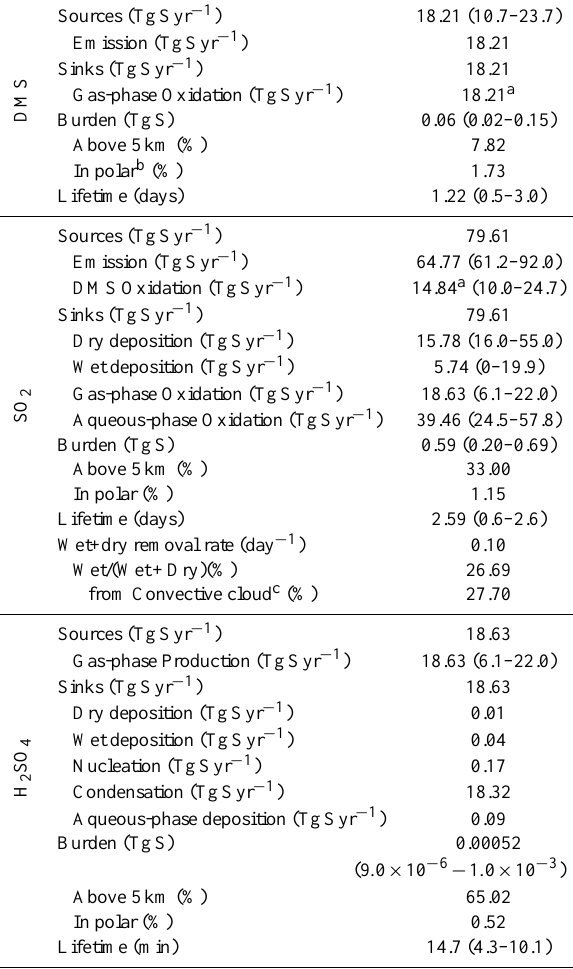
Table 1. Global annual budgets for DMS, SO 2 , and H 2 SO 4 . Values in the parenthesis show the range from other model studies, which include Liu et al. (2005) and those listed in Liu et al.